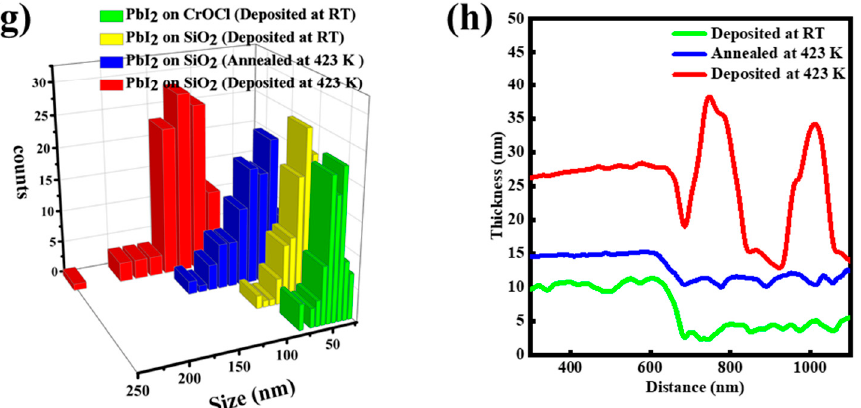
Figure 2. Surface morphology evolution of PbI 2 /CrOCl heterostructures fabricated with different conditions. ( a ) AFM image of PbI 2 films deposited at room temperature; ( b ) zoomed − in AFM image of PbI 2 /CrOCl from the white box area in figure; ( a , c ) AFM images of PbI 2 films annealed at 423 K after deposition; ( d ) zoomed − in AFM image of PbI 2 /CrOCl from the white box area in figure ( c , e ) AFM image of PbI 2 films deposited at 423 K; ( f ) zoomed − in AFM image of PbI 2 /CrOCl from the white box area in figure; ( e , g ) distribution of PbI 2 granule size for three samples; ( h ) corresponding line profiles across the CrOCl edges in the three samples. The histograms and profiles with green, blue, and red indicate the samples deposited at room temperature, annealed after deposition, and deposited at 423 K, respectively.